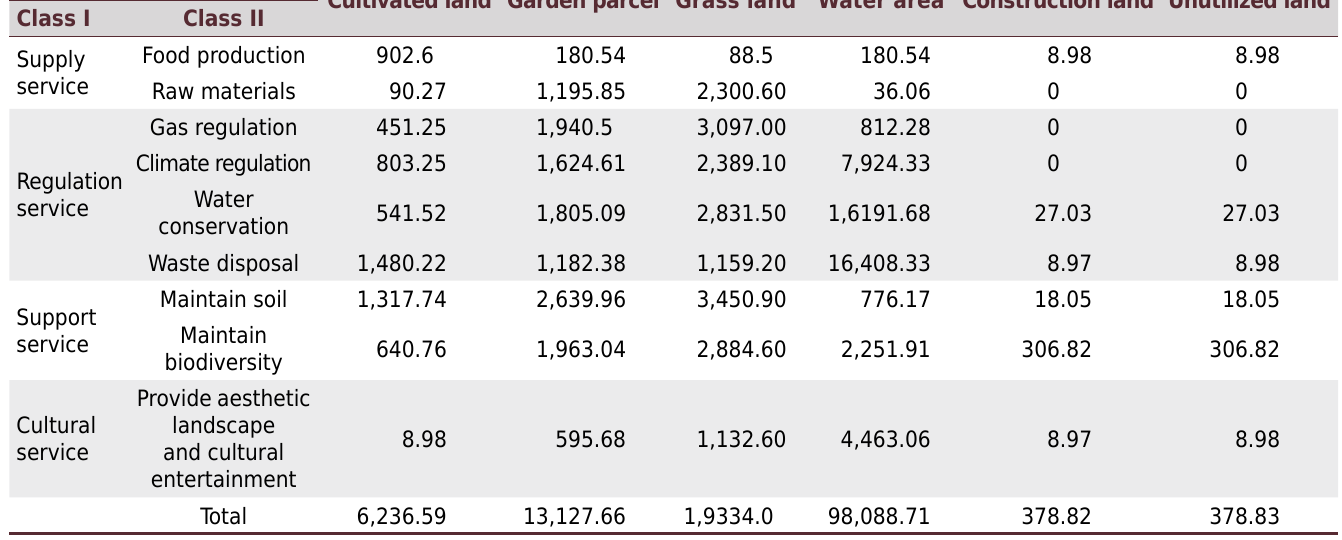
Table 6. List of ecosystem service values per unit area in Huanghua City, China (CNY ha·a)